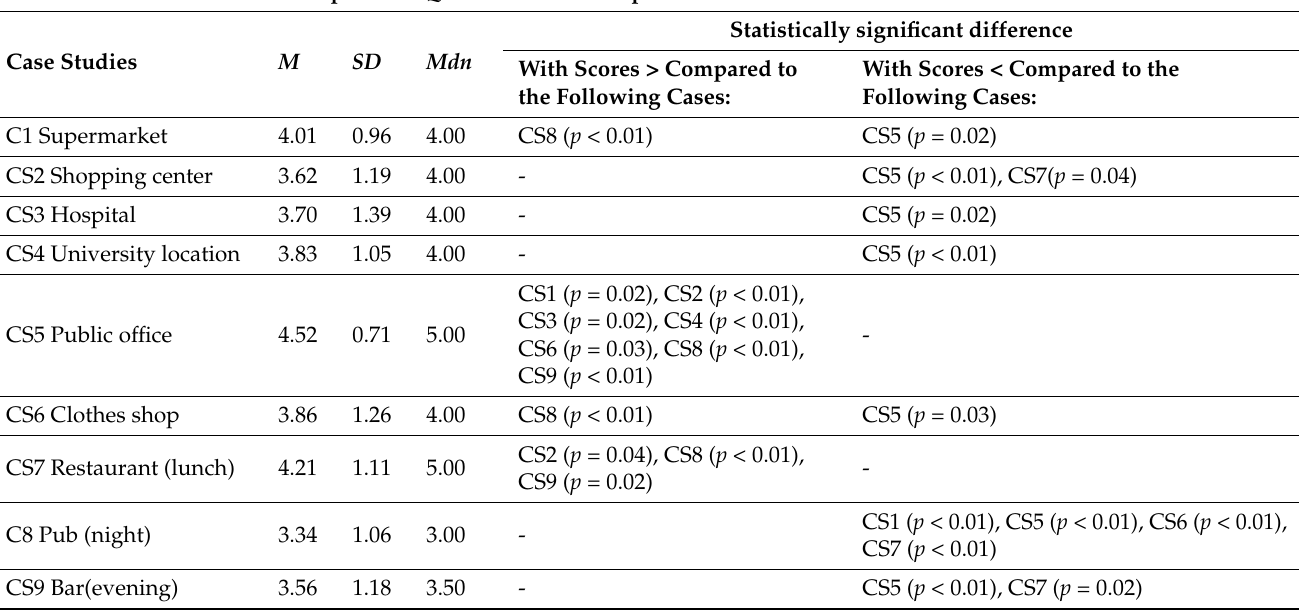
Table A13. Table shows the statistically significant differences ( p (BH)) that emerged from the comparison of item 10 in the different case studies (CS1–CS9). In the table is also reported the mean ( M ), the standard deviation ( SD ) and the median ( Mdn ). Own